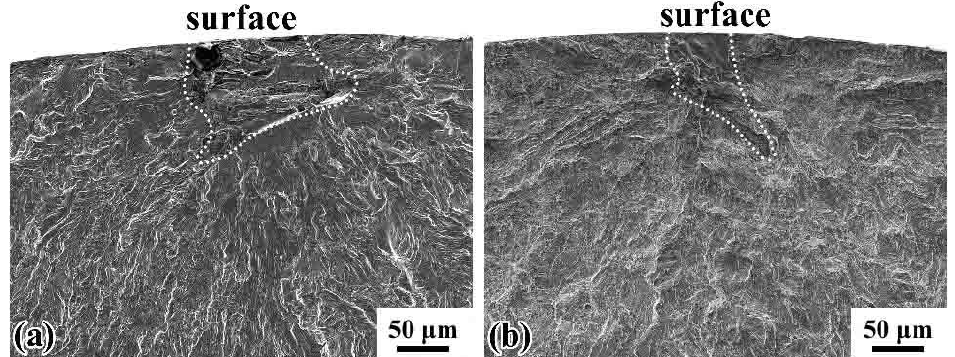
Figure 8. Typical fracture morphologies of surface crack initiation by ultrasonic fatigue test: ( a ) R =